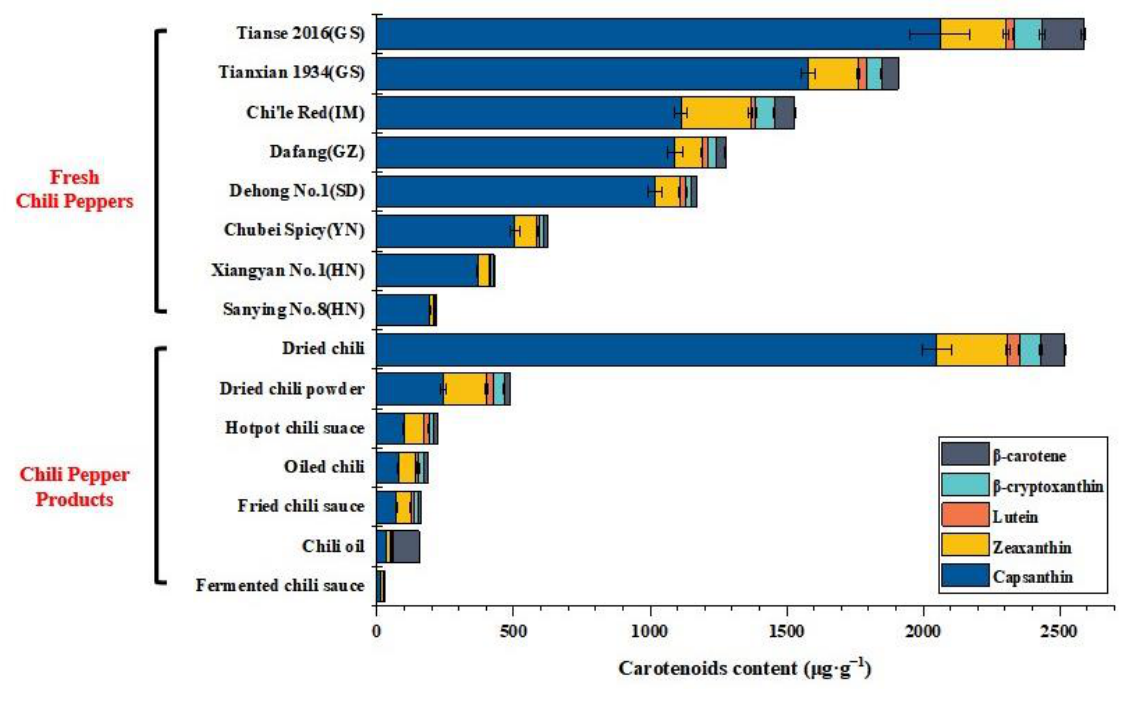
Figure 4. Contents of capsanthin, zeaxanthin, lutein, β - cryptoxanthin and β -carotene in common varieties of fresh chili peppers and chili pepper products (GS, IM, GZ, SD, YN and HN were abbreviations of Gansu, Inner-Monongalia, Guizhou, Shandong, Yunnan and Henan, which were the main provinces of planted chili peppers in China).